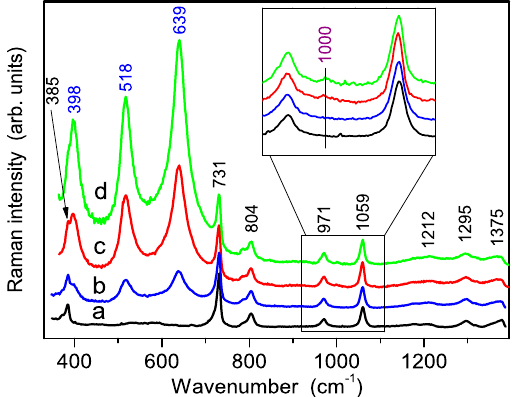
Figure 8. Experimental Raman spectra, carried out in the high wavenumber region, of pure Nafion membrane ( a ) and of three composite membranes with increasing amounts of TiO 2 nanopowders: 2% ( b ) 5% ( c ) and 7% ( d ). The inset report the spectra of SO 42 − groups in the region 950–1090 cm − 1 after proper magnification.